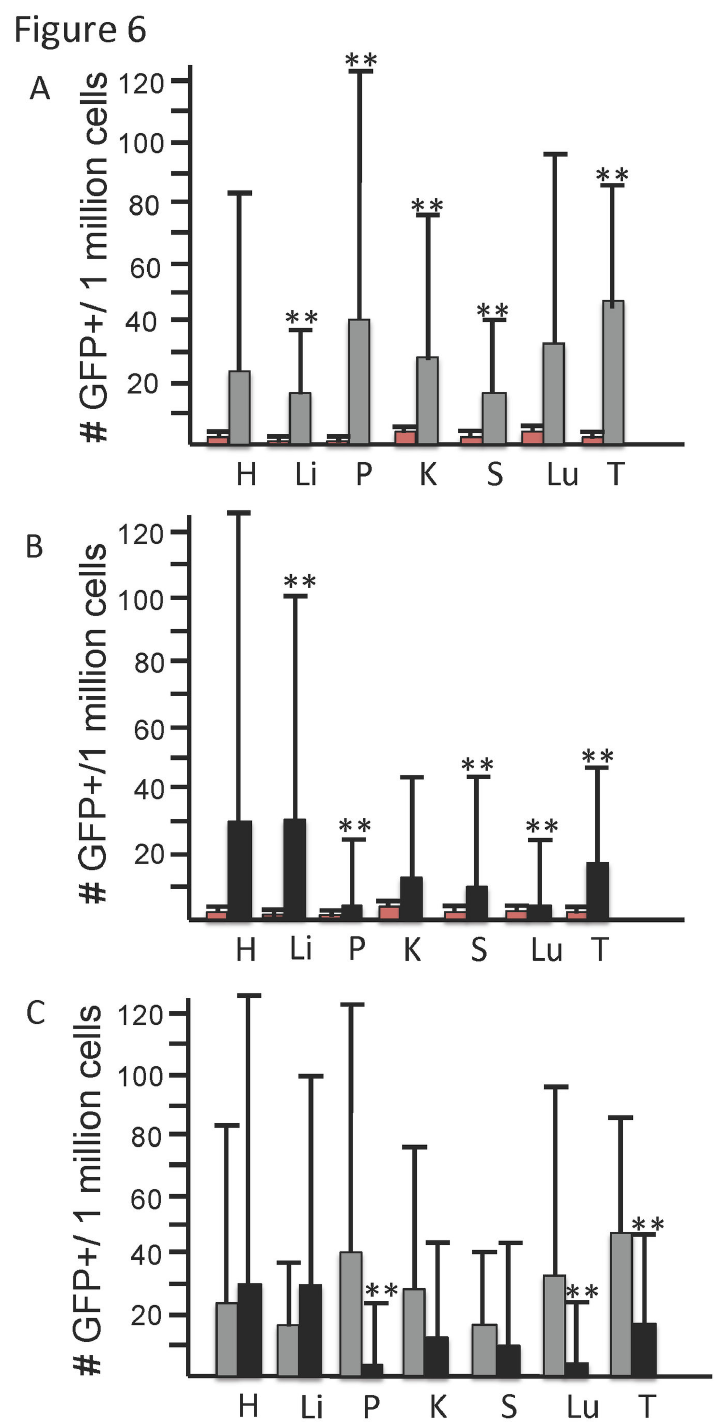
Figure 6. Quantitative analysis of GFP+ cells by age. ( A ) In the young mouse cohort (age<5.5 months), negative controls are shown in red bars (n=5), and +TET are shown in grey bars (n=16). Organs with statistically significant increased numbers of GFP+ cells groups are indicated by ** above the error bars. ( B ) In the older mouse cohort (age>8 months), negative controls are shown in red bars (n=11) and +TET are shown in black bars (n=31). ( C ) Comparison of +TET young mice (grey bars) versus +TET old mice (black bars) from A and B. Organs with statistically significant different numbers of GFP+ cells by age are indicated by ** above the error bars. For all panels, H=heart, P=pancreas, Li=liver, K=kidney, S=spleen, Lu=lung, T=thymus. doi: 10.1371/journal.pone.0084379.g006 PLOS ONE |